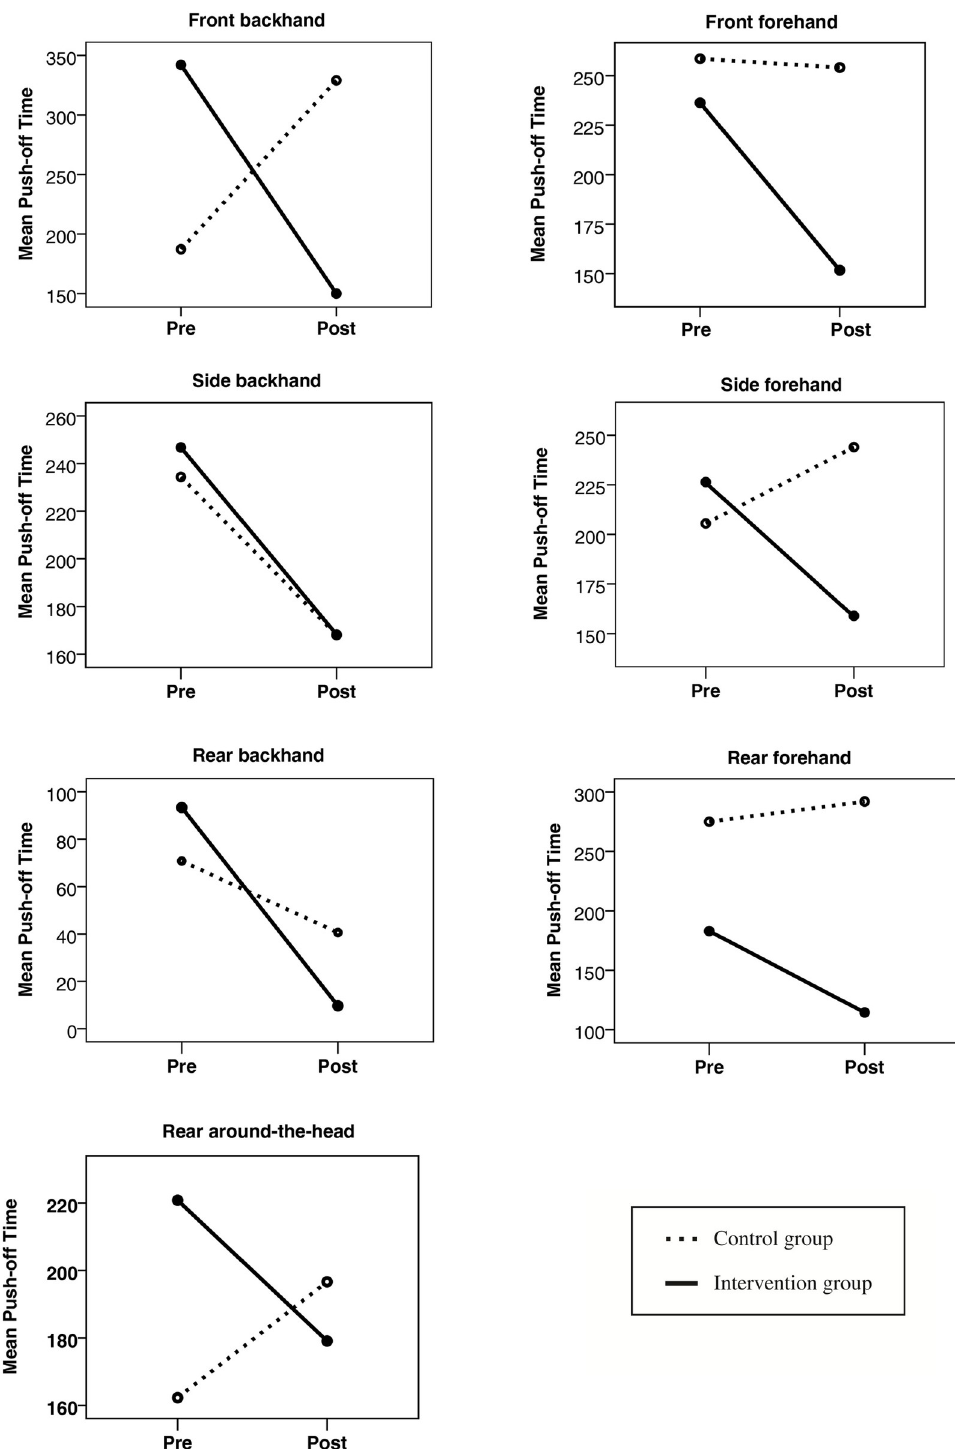
Fig 3. Pre- and post-intervention mean push-off times (in milliseconds) for different badminton shots in the control group and the intervention group. Pre = pre-intervention, Post = post-intervention.